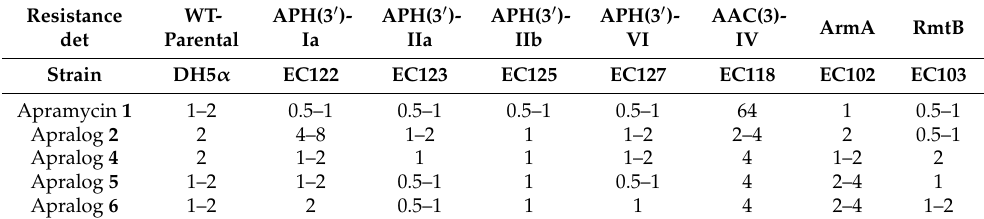
Table 3. Activities against E. coli in the Presence of Specific Resistance Determinants (MIC, µ g/mL) a .